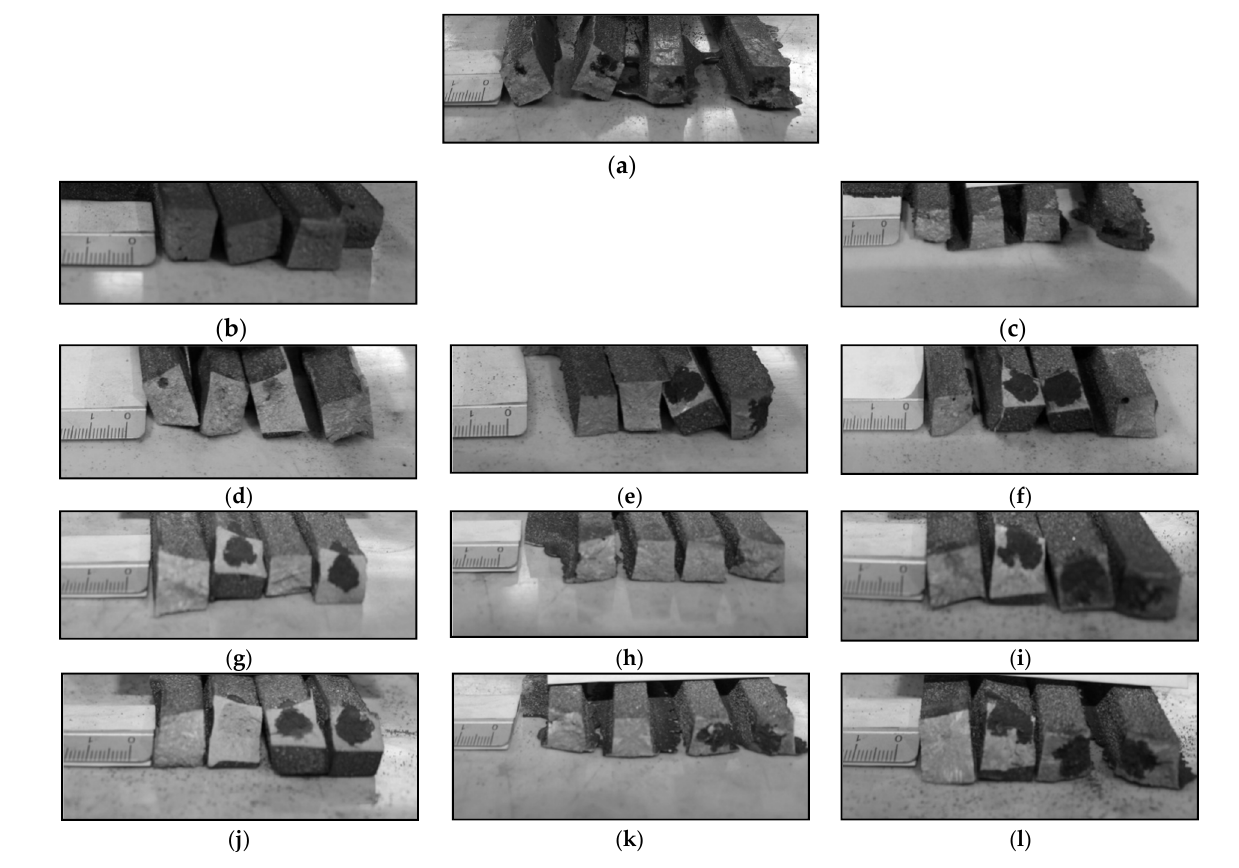
Figure 5. Results of Althoff-Radtke tests: ( a ) reference sample, inoculation; ( b ) KH 1; ( c ) KH 2; ( d ) 0.25% FeTi; ( e ) 0.50% FeTi; ( f ) 0.75% FeTi; ( g ) 0.17% Al; ( h ) 0.33% Al; ( i ) 0.50% Al; ( j ) 0.17% FeB; ( k ) 0.33% FeB; ( l ) 0.50% FeB for samples from left to right—50, 150, 250, and 350 mm. The dark areas indicate the local oxidation formed when the specimen fractured during solid-state shrinkage (hot cracking).